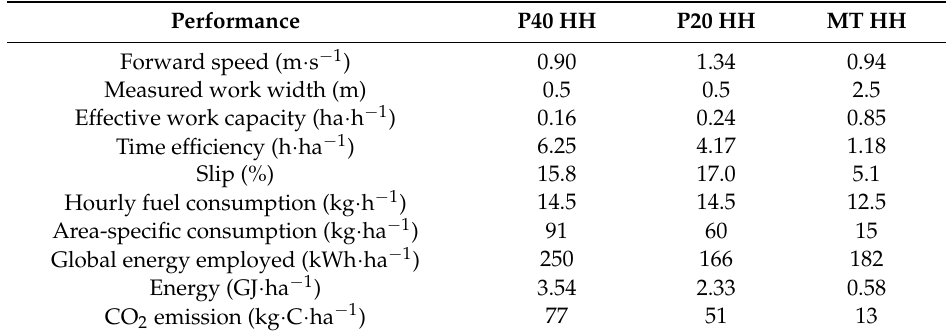
Table 5. Performance of tracked and wheeled tractors during soil tillage carried out at high soil water content HH (80% FC).